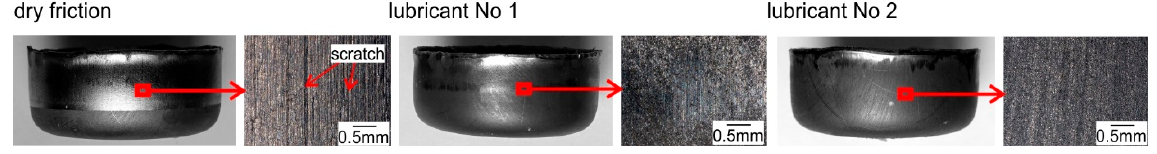
Figure 7. View of formed cylindrical cups. Table 5. Results of cylindrical cups forming.